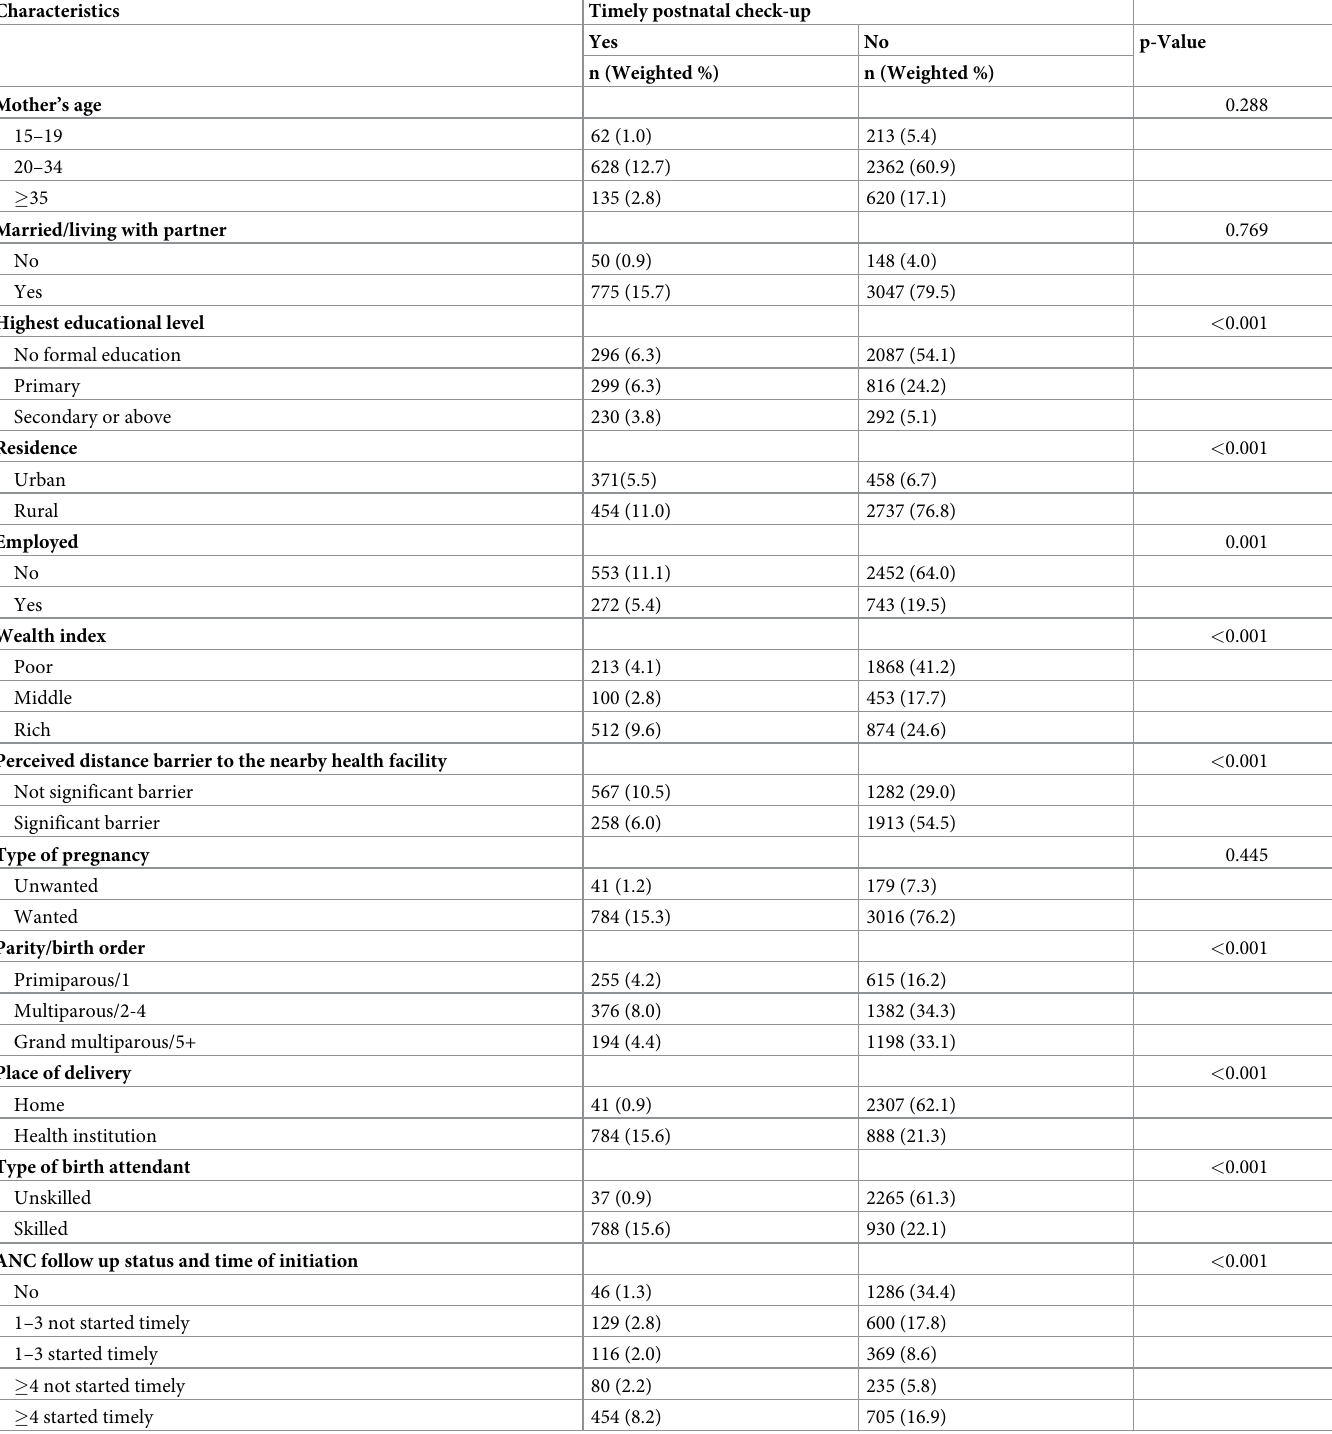
Table 2. Characteristics of the study sample by postnatal checkup within 2 days of delivery (N = 4081).